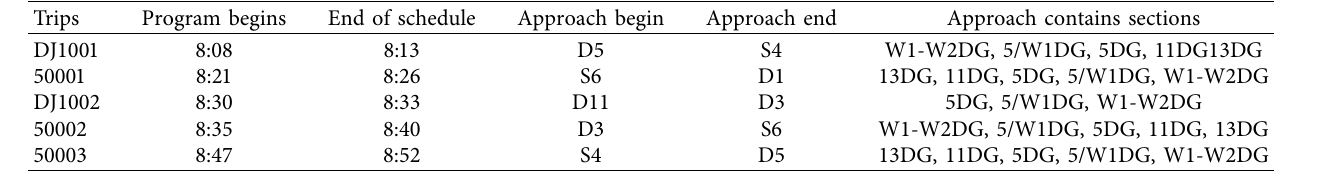
Table 2: 8:00–9:00 shunting operation plan at station A.